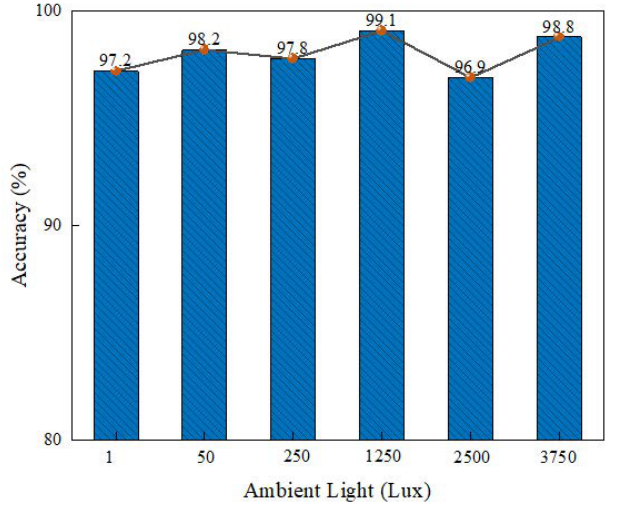
Figure 16. Impact of ambient light on recognition